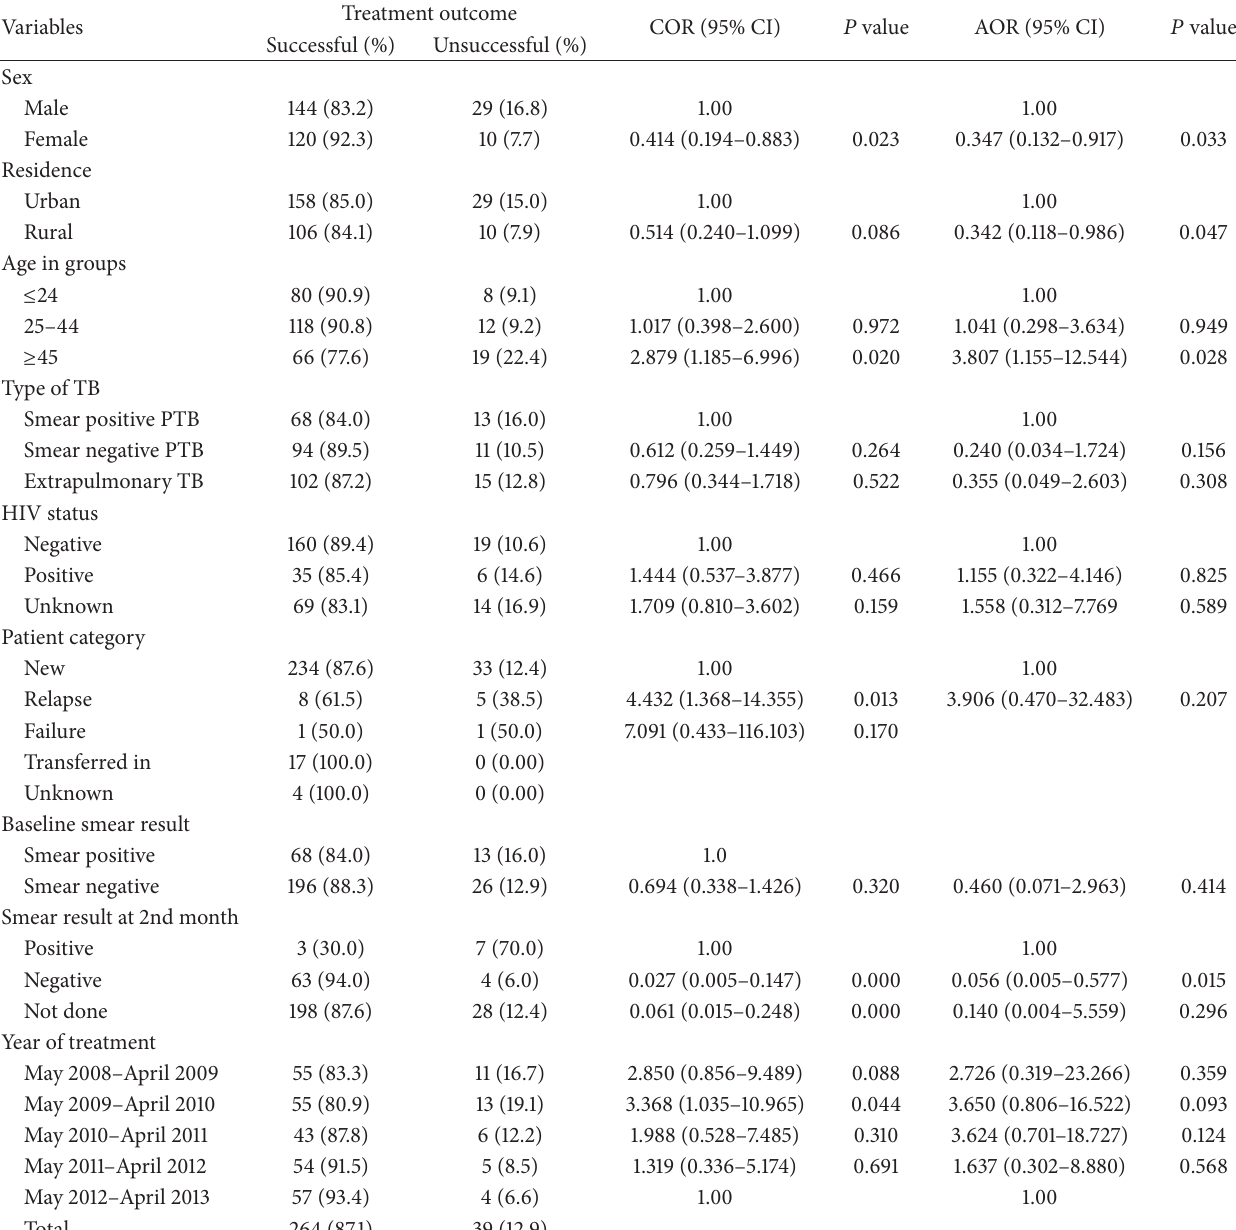
Table 4: Factors associated with treatment outcome of TB patients in Debre Tabor, 2008–2013, 𝑁 = 303